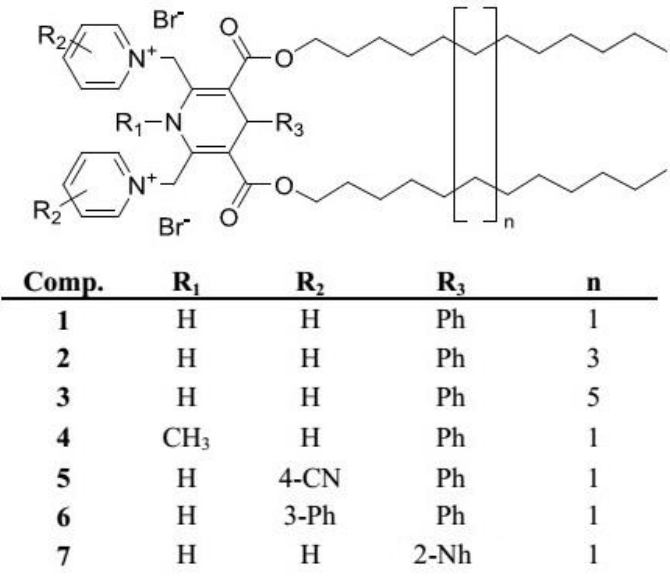
Figure 2. Structures of the studied 1,4-DHP amphiphiles 1 – 7 . 1,1 (cid:48) -[(3,5-Bisdodecyloxycarbonyl-4-phenyl-1,4-dihydropyridine-2,6-diyl)dimethylen]bis(pyridin-1-ium) (or substituted pyridinium) dibromides ( 1 , 5 , 6 ), 1,1 (cid:48) -[(3,5-dialkoxycarbonyl-4-phenyl-1,4-dihydropyridine-2,6-diyl)dimethylen]bis(pyridine-1-ium) dibromides ( 2 , 3 ) and 1,1 (cid:48) -[(3,5-didodecyloxy-carbonyl-4-(2-napthyl)-1,4-dihydropyridine-2,6-diyl)dimethylen]bis(pyridin-1-ium) dibromide ( 7 ) were obtained according to Scheme S1 (Supplementary data). Briefly, the corresponding parents 3,5-bis(alkoxycarbonyl)-2,6-dimethyl-4-aryl-1,4-dihydropyridines were obtained by the classical Hantzsch synthesis from the corresponding acetoacetic ester, the corresponding aldehyde and ammonium acetate [38].